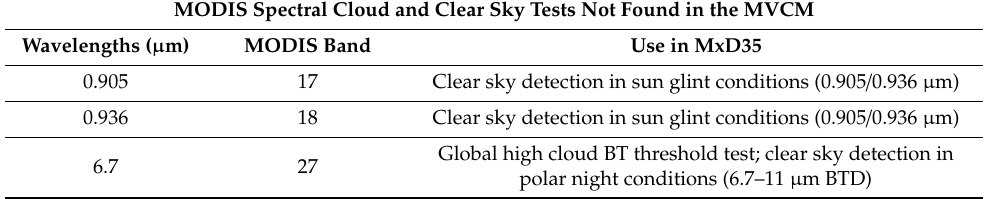
Table 2. Spectral bands and uses in MxD35 that are not part of the MVCM. BT and BTD represent the brightness temperature and brightness temperature di ff erence,